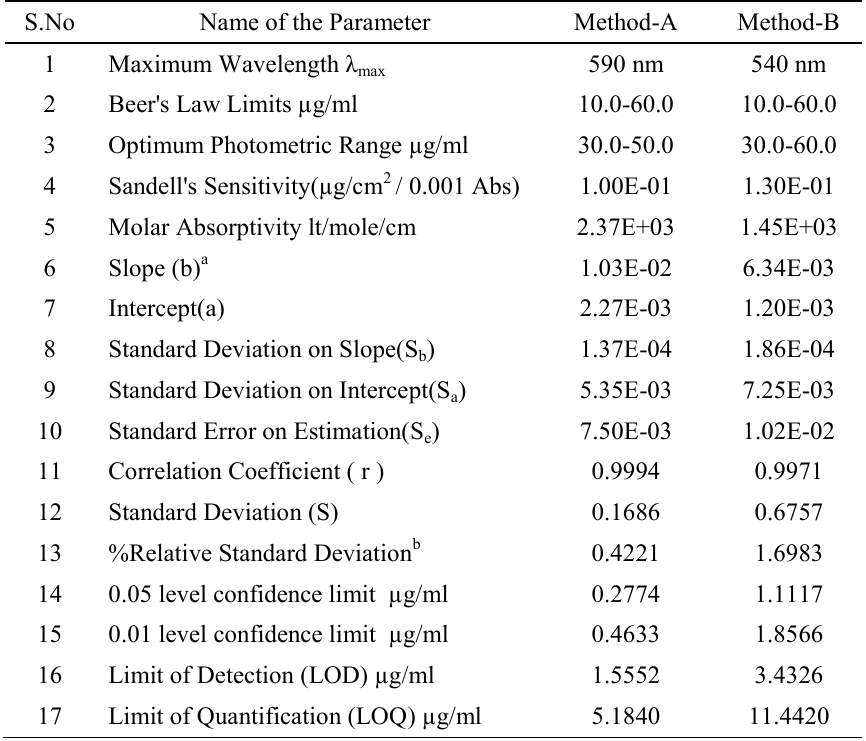
Table 1. Spectral, Optical characteristics, Regression parameters, Precision, and Accuracy of the proposed